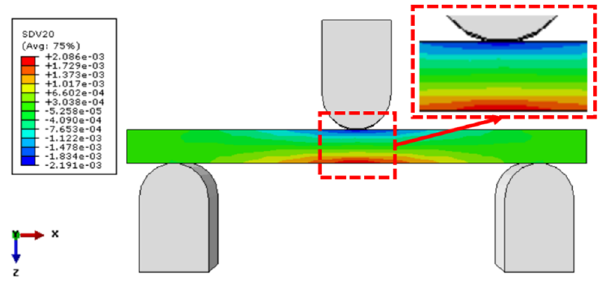
Figure 13. The   on the sample surface. Figure 13. The ε xx on the sample surface.